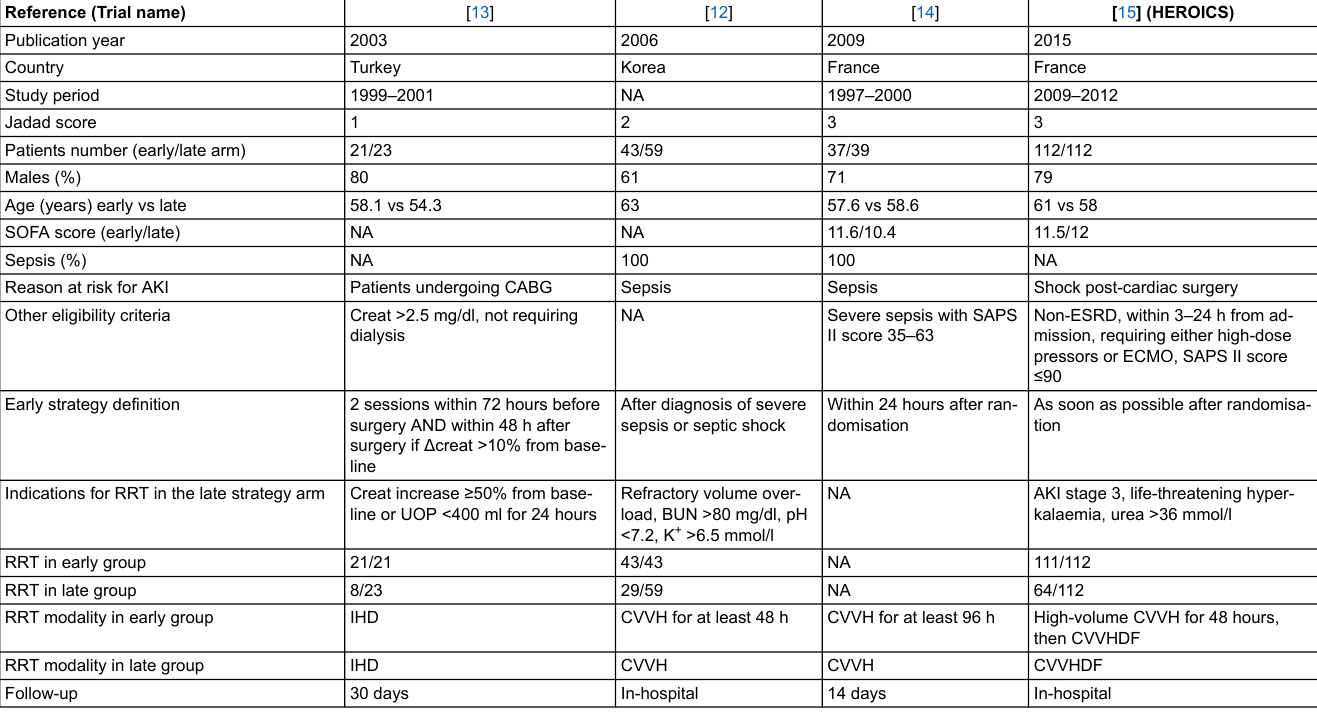
Table 3: Characteristics of the selected studies in patients at risk for acute kidney